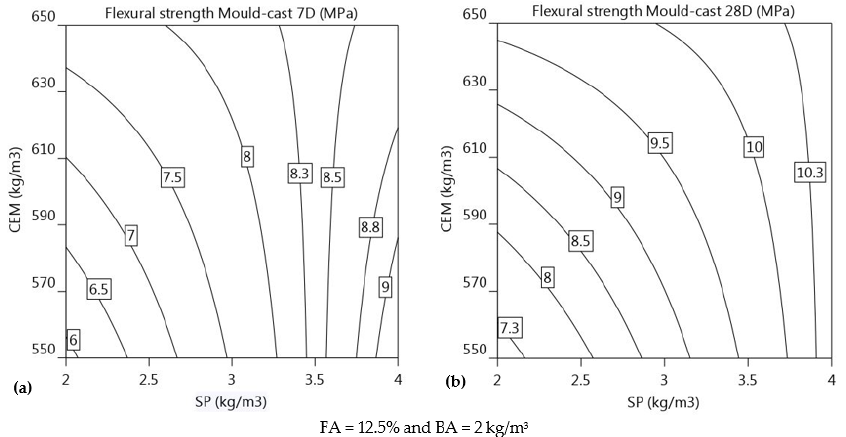
Figure 11. Isoresponse curves for flexural strength of mould-cast members ( a ) CEM versus SP at 7 days, and ( b ) CEM versus SP at 28 days.